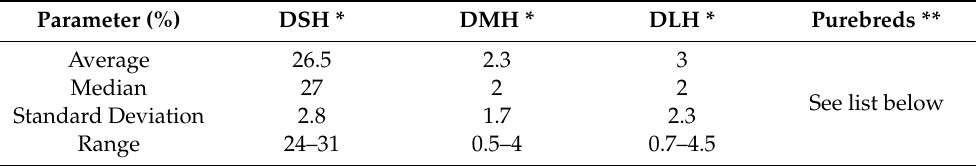
Table 1. Summary of 1000 feline cases by breed type.